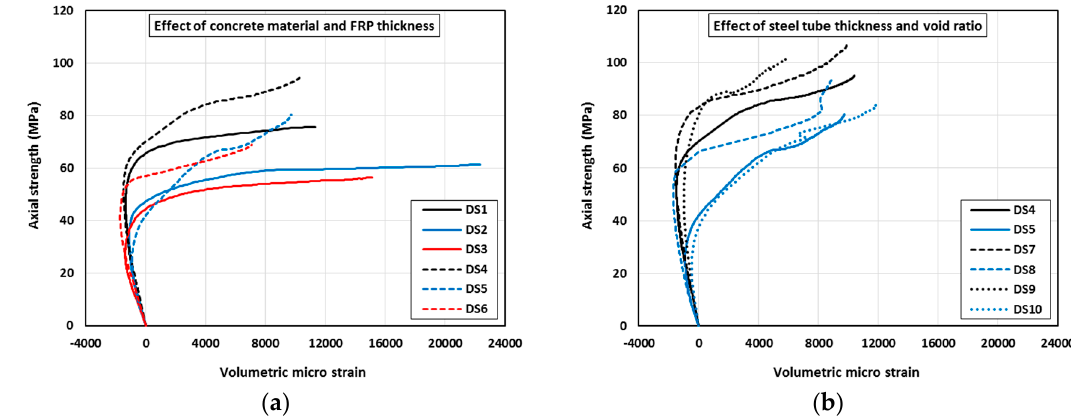
Figure 9. Volumetric strain behaviour versus applied axial stress of some tested specimens: ( a ) Effect of concrete material and FRP thickness, and ( b ) effect of steel tube thickness and void ratio.